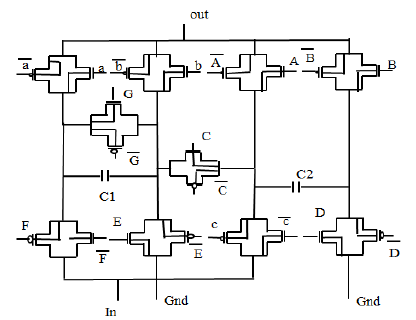
Figure 7. Circuit diagram of transmission gate-based switch capacitor converter using CMOS.